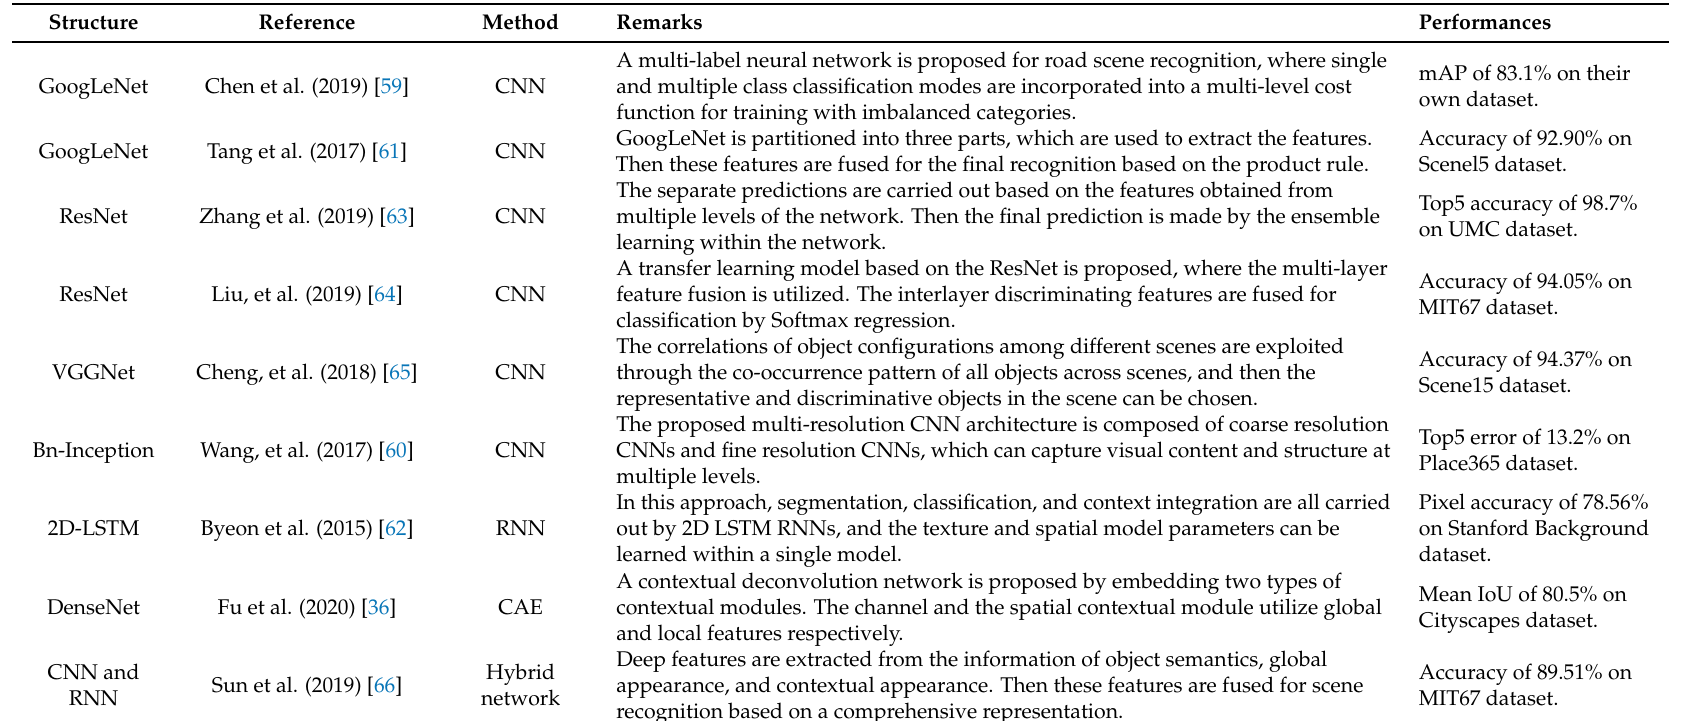
Table 3. A summary of the deep learning method-based scene recognition